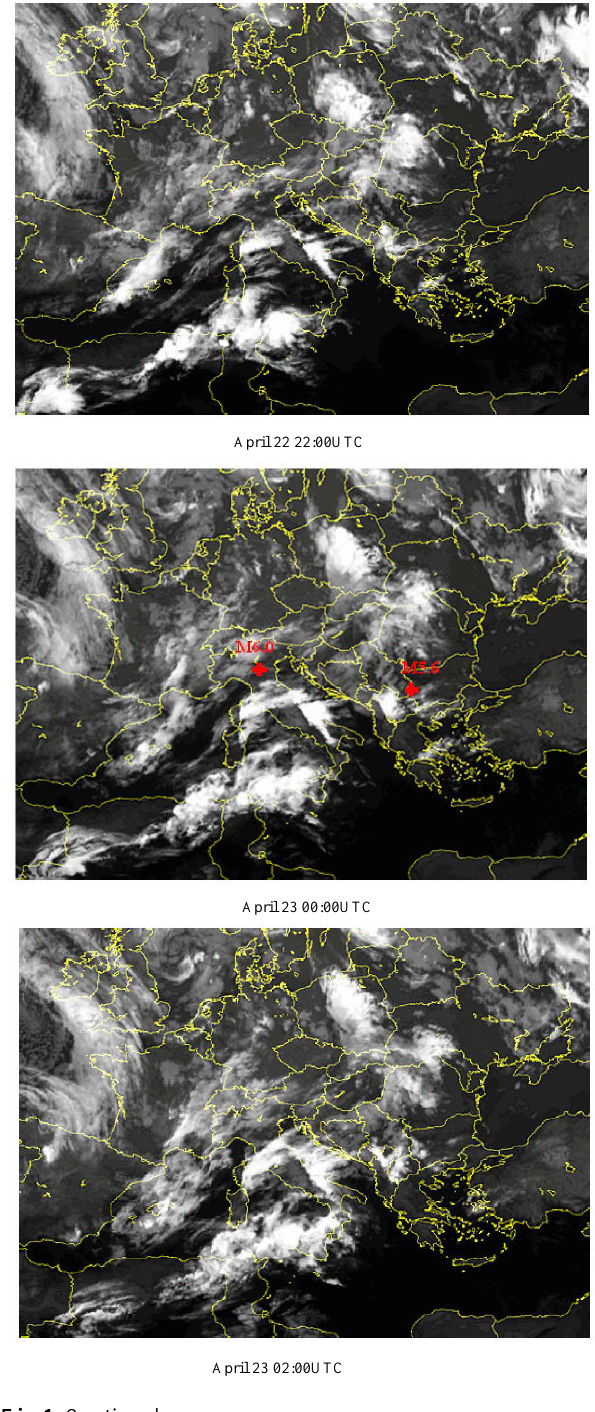
Figure 1. Geostationary satellite image of Europe from April 22, 18: 00 UTC to April Fig. 1. 23, 02:00 UTC